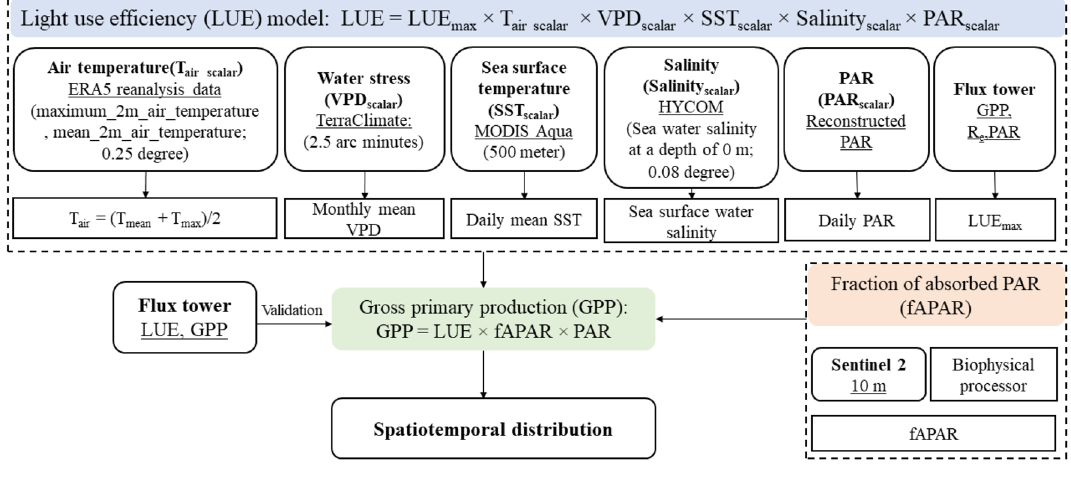
Figure 8. Overall flowchart of GPP